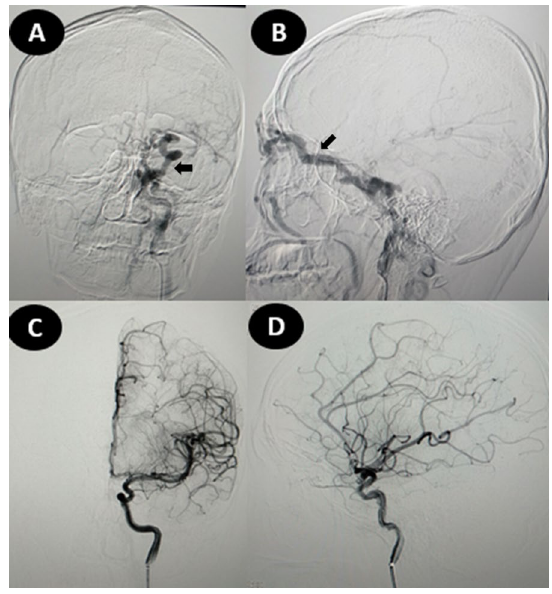
Fig. 1 Case 9, 25-year-old female. Initial anteroposterior and lateral view angiogram ( A , B , respectively) revealed type A high-flow fistula with venous drainage via SOV (arrows). The fistula was occluded using detachable balloon, and post-procedure angiogram